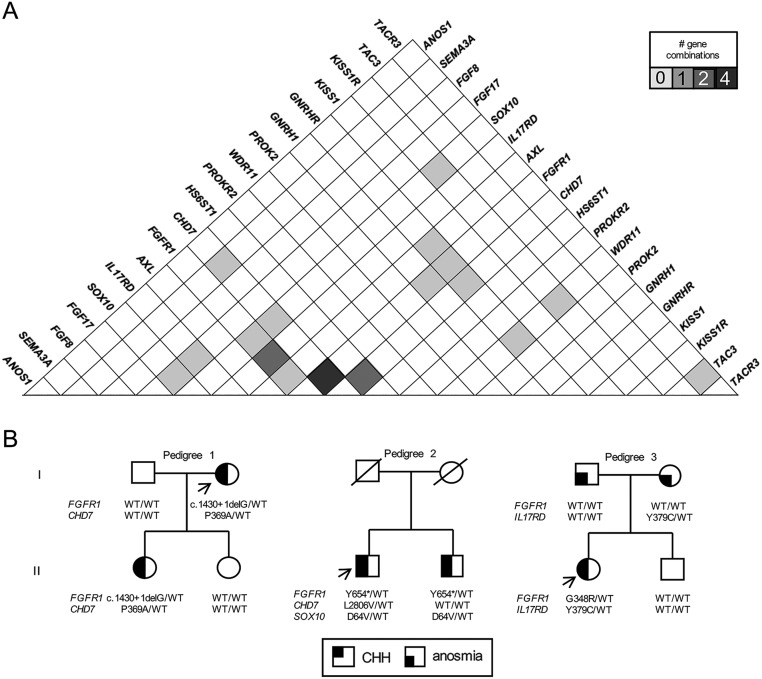

FGFR1 and CHD7 are frequently inherited in digenic fashion among CHH probands. (A) Matrix showing shading-coded frequencies CHH genes digenic combinations. (B) Available pedigrees of CHH probands displaying oligogenic inheritance. Circles denote females; squares denote males; arrows depict probands; WT denotes wild-type.